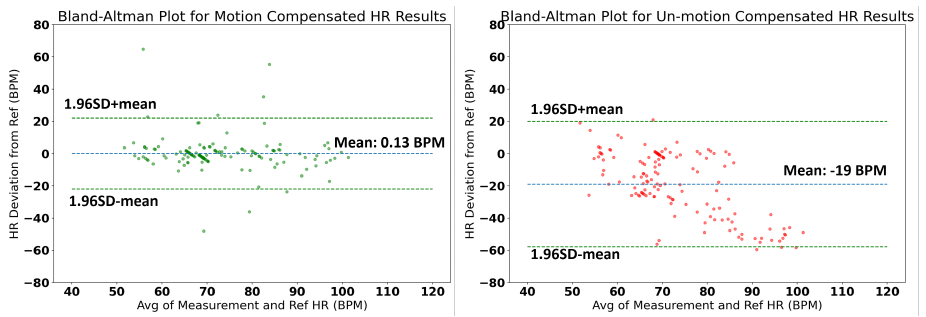
Figure 12. Bland–Altman plot of HR measurements when participants sit in the passenger seat on the highway with motion compensation ( left ) and without motion compensation ( right